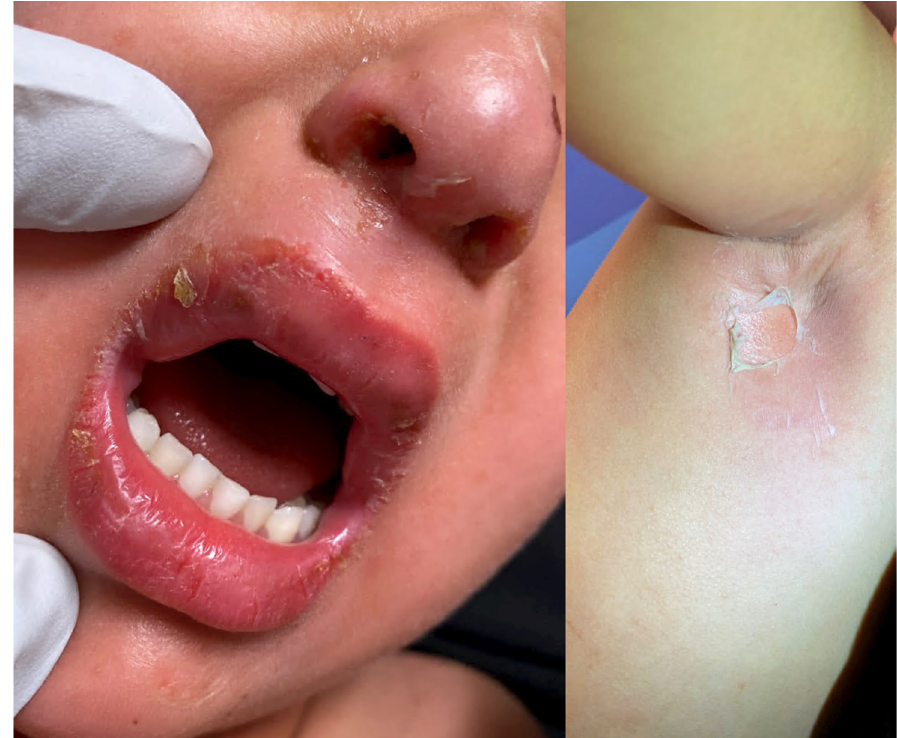
Figure 1. Staphylococcal scalded skin syndrome. Superficial blistering on the face ( left ) and in the axilla ( right ). Original image provided by Kiran Motaparthi, MD. Table 1. Clinical features of children and adults with SSSS .